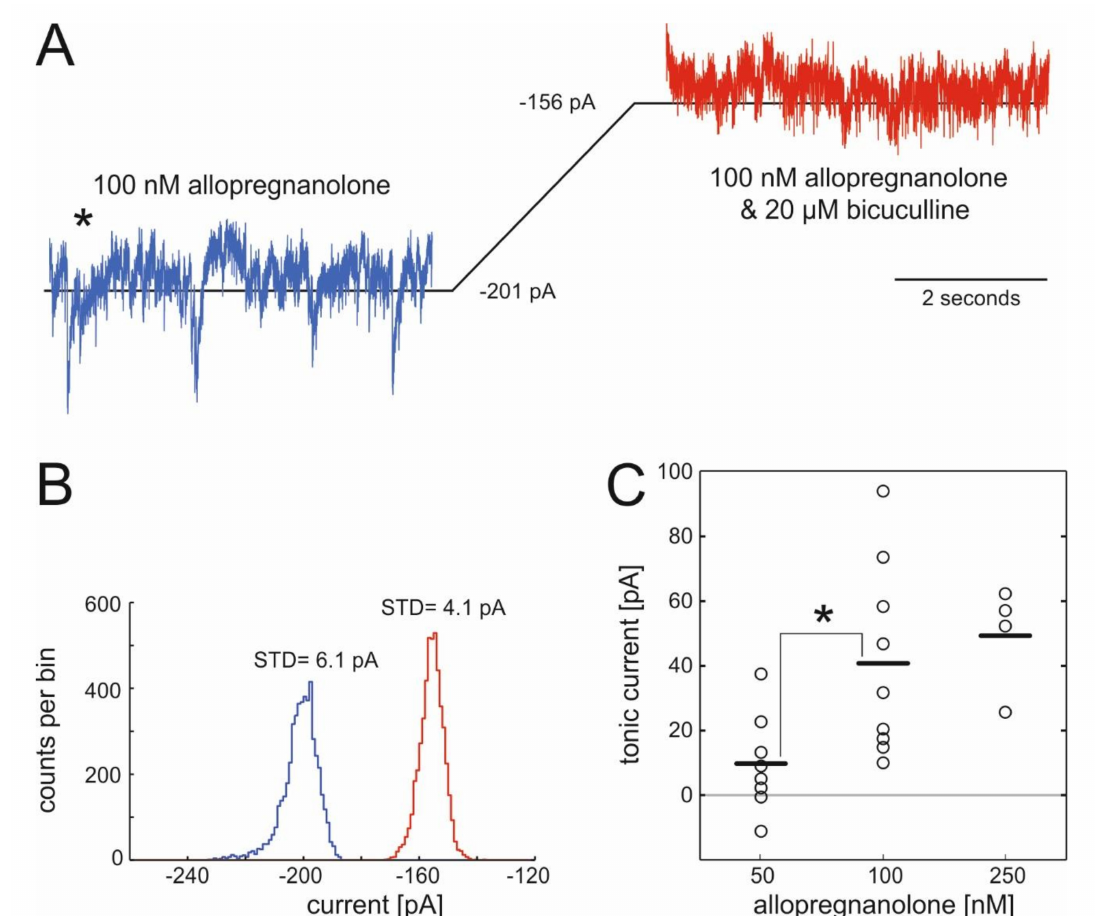
Figure 1. Actions of allopregnanolone on tonic currents in spinal interneurons of the ventral horn. ( A ) Example of a whole-cell voltage-clamp recording made from a spinal interneuron in the ventral horn at a holding potential of − 70 mV in the presence of AP-V ( dl -2-amino-5-phosphonopentanoic acid), CNQX (6-cyano-7-nitro-quinoxaline-2,3-dione), and strychnine (to block glutamatergic and glycinergic currents), and 100 nM allopregnanolone (ALLO). After the wash-in of 20 µ M bicuculline, the inhibitory postsynaptic currents (IPSCs) suspended and the baseline shifted from − 201 pA to − 156 pA. ( B ) All-point histogram of the recording presented in ( A ) given as counts per bin, illustrating the shift in the baseline current induced by 20 µ M bicuculline in the presence of 100 nM ALLO. The reduction of the standard deviation from 6.1 pA to 4.1 pA is caused by the blockade of synaptic events (IPSCs). ( C ) Summary: ALLO induces tonic currents in spinal interneurons, 50 nM: 9.7 ± 5.3 pA ( n = 8), p = 0.11; 100 nM: 40.8 ± 9.8 pA ( n = 9); p = 0.003 and 250 nM: 49.3 ± 8.2 pA ( n = 4), p = 0.009; horizontal lines = mean, * = p < 0.05, t -test.